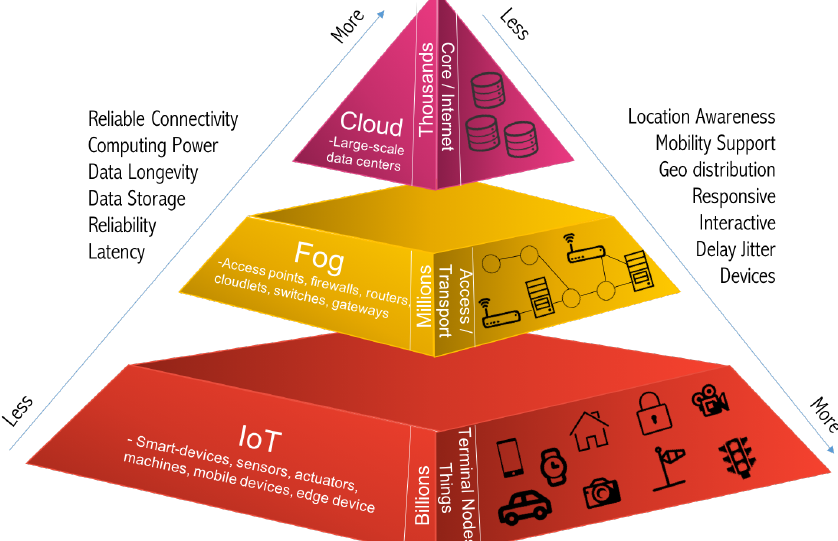
Figure 1. IoT–fog–cloud layered